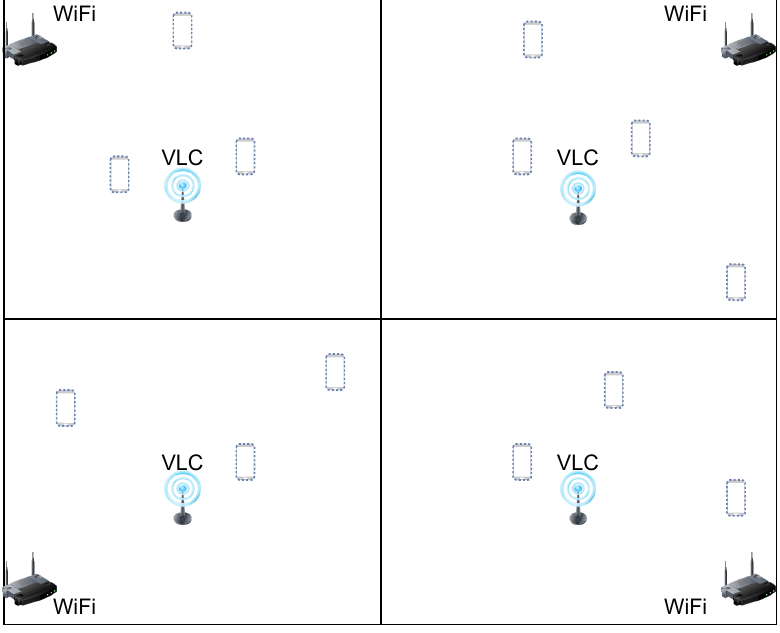
Figure 1. Hybrid VLC-WiFi Network